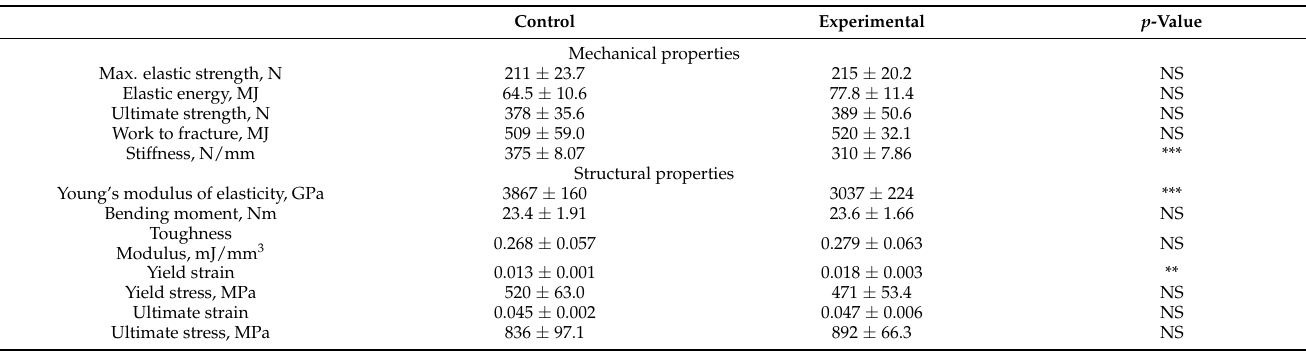
Table 2. The effect of C. perfringens infection on biomechanical properties of the tibia in examined animals at the age of 42